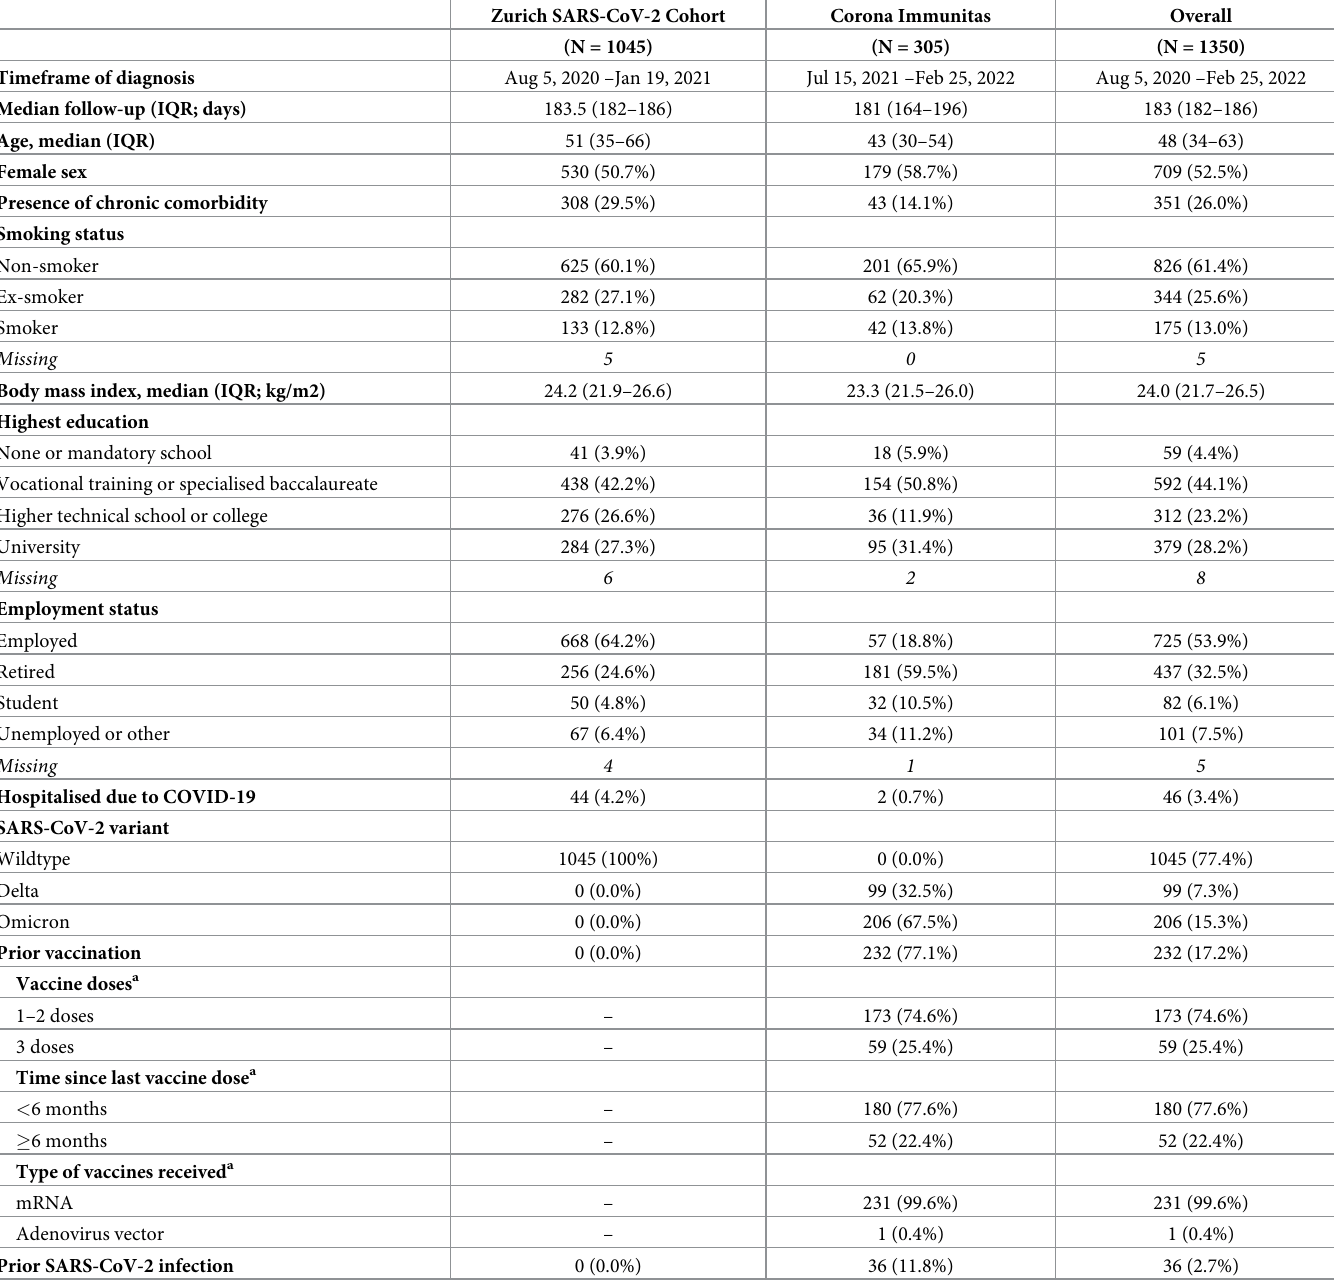
Table 1. Participant characteristics of Wildtype, Delta, or Omicron SARS-CoV-2-infected individuals from the Zurich SARS-CoV-2 Cohort and the Corona Immu- nitas Phase 5 seroprevalence studies. Zurich SARS-CoV-2 Cohort Corona